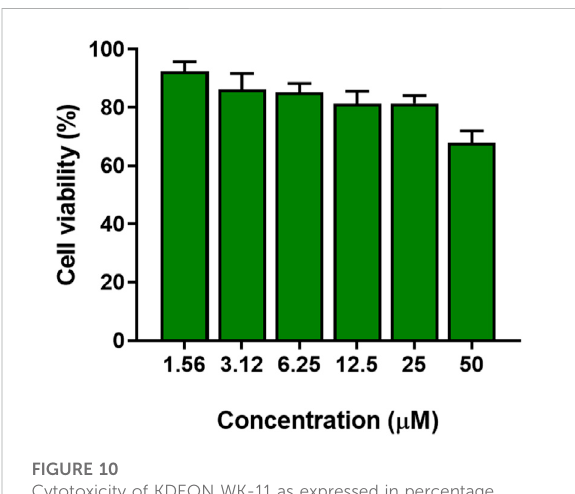
FIGURE 10 Cytotoxicity of KDEON WK-11 as expressed in percentage cell viability assessed by the MTT assay testing varying concentrations of peptide from 1.56 to 50 μ M. Data represent the mean ± SEM of three independent